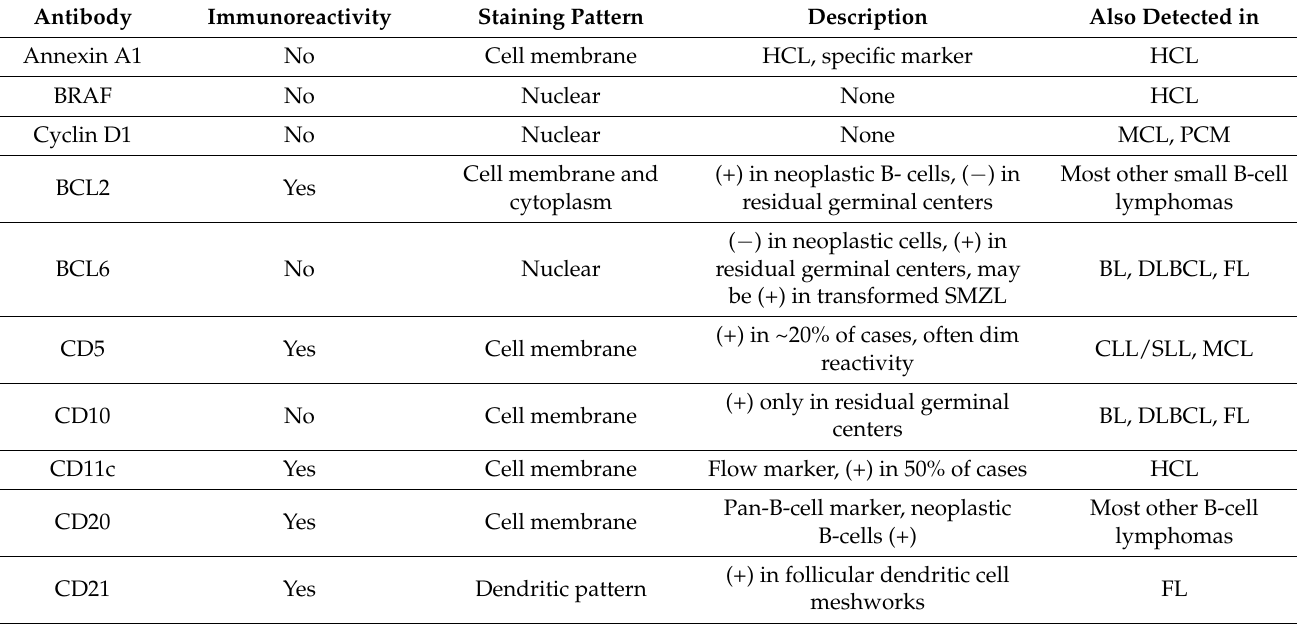
Table 2. Phenotyping splenic marginal zone lymphoma and its differential